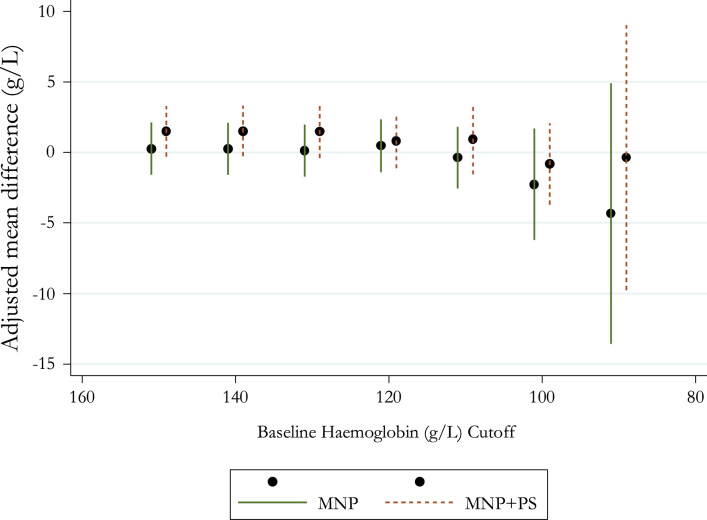
Coefficient plot of estimated effects of MNP on haemoglobin for subgroups of children with baseline haemoglobin below successively lower thresholds. For each baseline haemoglobin cut-off on the x-axis the plot shows the estimated effect of MNP on follow-up haemoglobin for the subgroup of children whose baseline haemoglobin was below that cut-off. Points represent point estimates and bars represent the 95% confidence interval around each estimate. All estimated effects adjusted for sex, tester, region, second order polynomials in age and altitude and baseline haemoglobin using linear regression. Confidence intervals adjusted for clustering at the town level.